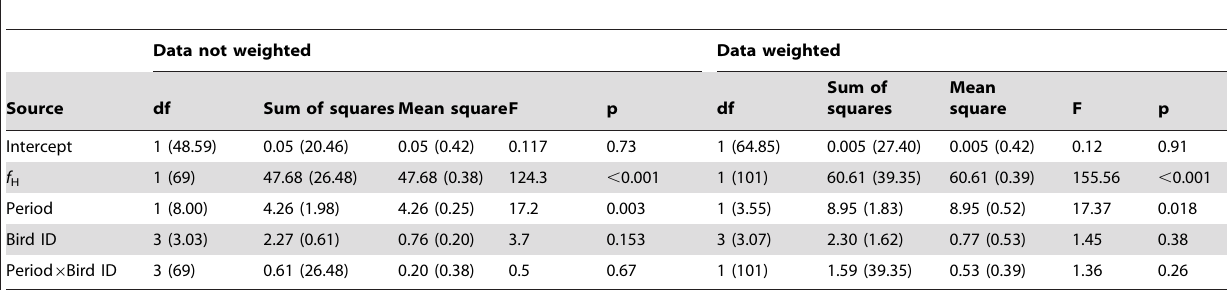
Table 1. ANCOVA results 1,2 from analysis of the effects of individual birds (Bird ID, random categorical factor) and the period of the measurements (day/night, fixed categorical factor) on the relationship between f H (covariate) and _ VV O 2 in European bee-eaters.